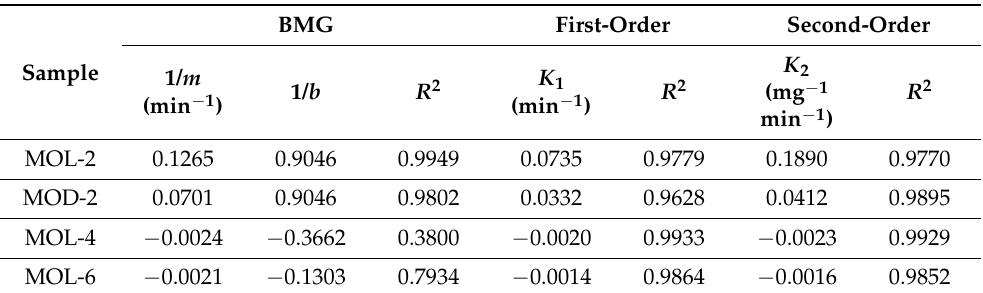
Table 2. The main extracted parameters for the photodegradation of MO based on the three kinetic